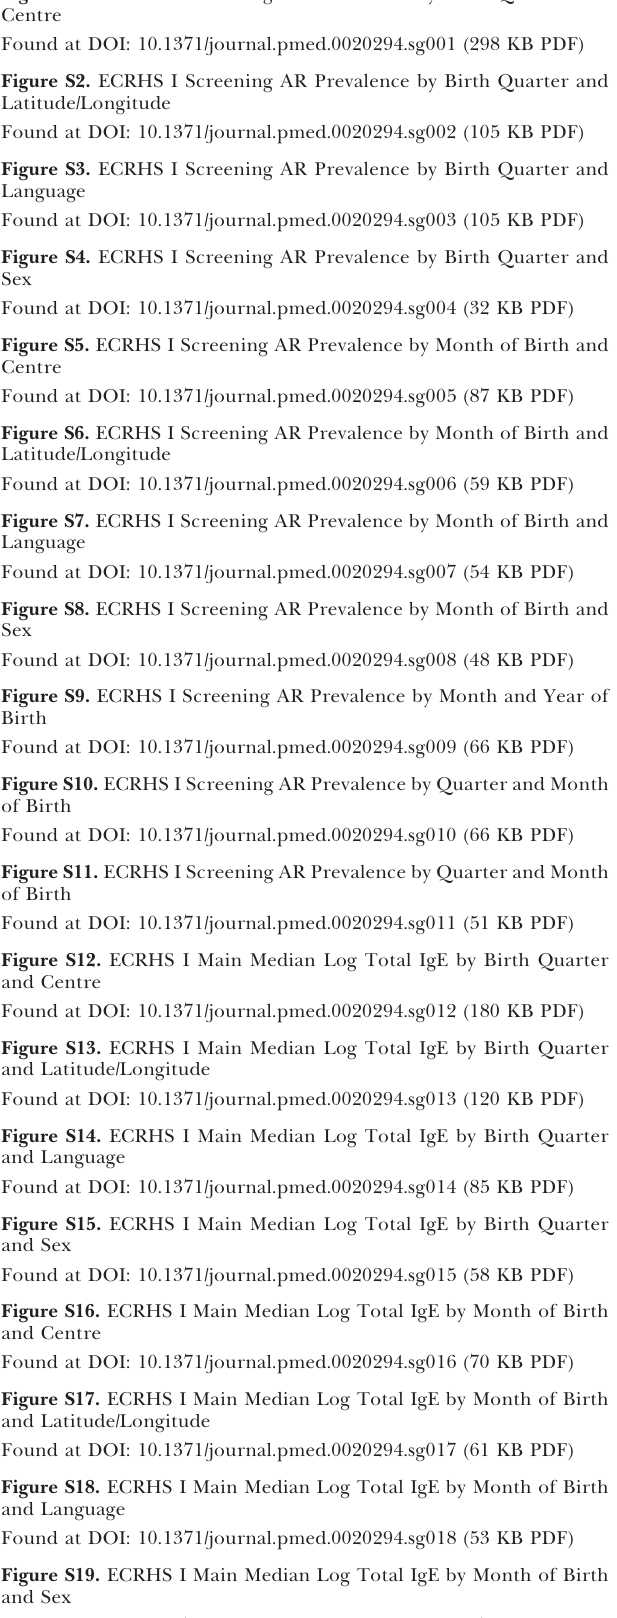
Figure S1. ECRHS I Screening AR Prevalence by Birth Quarter and Centre Found at DOI: 10.1371/journal.pmed.0020294.sg001 (298 KB PDF) Figure S2. ECRHS I Screening AR Prevalence by Birth Quarter and Latitude/Longitude Found at DOI: 10.1371/journal.pmed.0020294.sg002 (105 KB PDF) Figure S3. ECRHS I Screening AR Prevalence by Birth Quarter and Language Found at DOI: 10.1371/journal.pmed.0020294.sg003 (105 KB PDF) Figure S4. ECRHS I Screening AR Prevalence by Birth Quarter and Sex Found at DOI: 10.1371/journal.pmed.0020294.sg004 (32 KB PDF) Figure S5. ECRHS I Screening AR Prevalence by Month of Birth and Centre Found at DOI: 10.1371/journal.pmed.0020294.sg005 (87 KB PDF) Figure S6. ECRHS I Screening AR Prevalence by Month of Birth and Latitude/Longitude Found at DOI: 10.1371/journal.pmed.0020294.sg006 (59 KB PDF) Figure S7. ECRHS I Screening AR Prevalence by Month of Birth and Language Found at DOI: 10.1371/journal.pmed.0020294.sg007 (54 KB PDF) Figure S8. ECRHS I Screening AR Prevalence by Month of Birth and Sex Found at DOI: 10.1371/journal.pmed.0020294.sg008 (48 KB PDF) Figure S9. ECRHS I Screening AR Prevalence by Month and Year of Birth Found at DOI: 10.1371/journal.pmed.0020294.sg009 (66 KB PDF) Figure S10. ECRHS I Screening AR Prevalence by Quarter and Month of Birth Found at DOI: 10.1371/journal.pmed.0020294.sg010 (66 KB PDF) Figure S11. ECRHS I Screening AR Prevalence by Quarter and Month of Birth Found at DOI: 10.1371/journal.pmed.0020294.sg011 (51 KB PDF) Figure S12. ECRHS I Main Median Log Total IgE by Birth Quarter and Centre Found at DOI: 10.1371/journal.pmed.0020294.sg012 (180 KB PDF) Figure S13. ECRHS I Main Median Log Total IgE by Birth Quarter and Latitude/Longitude Found at DOI: 10.1371/journal.pmed.0020294.sg013 (120 KB PDF) Figure S14. ECRHS I Main Median Log Total IgE by Birth Quarter and Language Found at DOI: 10.1371/journal.pmed.0020294.sg014 (85 KB PDF) Figure S15. ECRHS I Main Median Log Total IgE by Birth Quarter and Sex Found at DOI: 10.1371/journal.pmed.0020294.sg015 (58 KB PDF) Figure S16. ECRHS I Main Median Log Total IgE by Month of Birth and Centre Found at DOI: 10.1371/journal.pmed.0020294.sg016 (70 KB PDF) Figure S17. ECRHS I Main Median Log Total IgE by Month of Birth and Latitude/Longitude Found at DOI: 10.1371/journal.pmed.0020294.sg017 (61 KB PDF) Figure S18. ECRHS I Main Median Log Total IgE by Month of Birth and Language Found at DOI: 10.1371/journal.pmed.0020294.sg018 (53 KB PDF) Figure S19. ECRHS I Main Median Log Total IgE by Month of Birth and Sex Found at DOI: 10.1371/journal.pmed.0020294.sg019 (47 KB